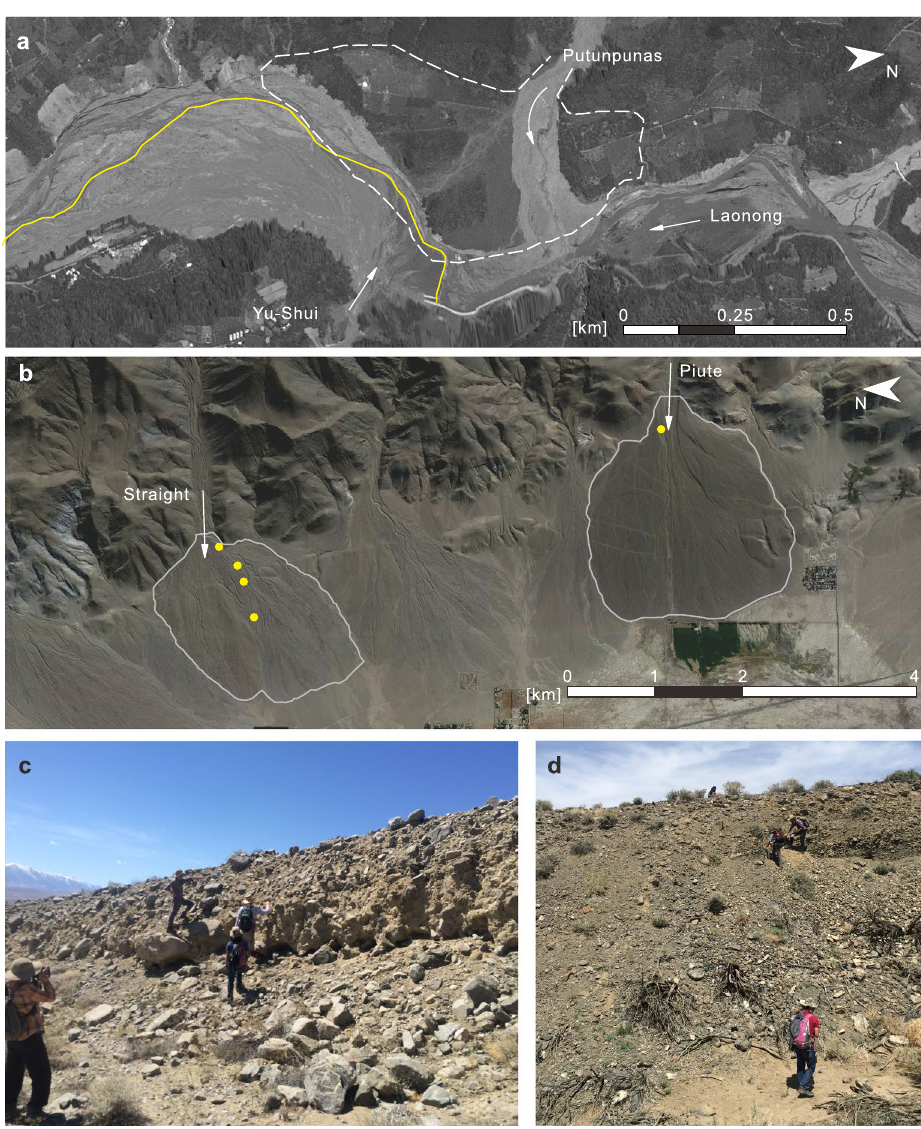
Figure 1. Examples of debris-flow dominated alluvial fans in the field, from ( a ) Laonong River Valley, Taiwan and ( b – d ) Owen’s Valley, White Mountains, California, US. ( a ) Laonong river’s satellite image in August, 2021. (1) white lines indicate the DEM-determined Pu-tun-pu-nas fan boundary in February 2020; (2) yellow lines(solid/dash) indicate the DEM-determined Yu-Shui fan boundary in August 2021 ( b ). ( b ) Owens Valley satellite image, September 2019. White lines denote DEM-determined fan boundaries for Straight and Piute. Yellow dots indicate sampling locations. ( c , d ), photos with (researchers for scale) on the channel levees in ( c ) straight and ( d )